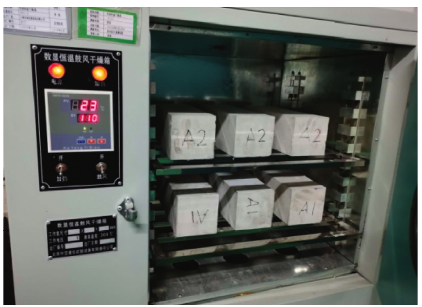
Figure 3: Drying process of specimens.